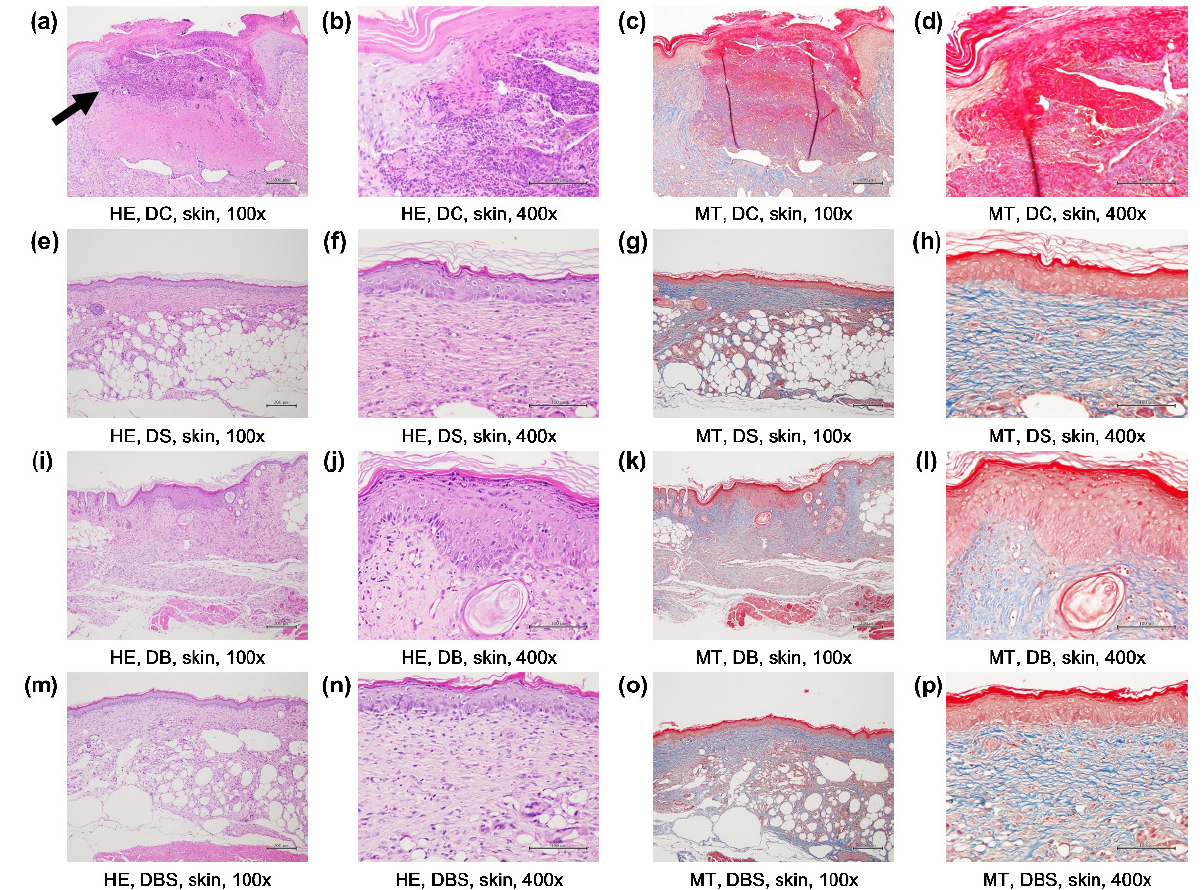
Figure 5. Histopathological analysis of skin wounds treated with different dressings. Histopatho- logical findings upon hematoxylin and eosin (H&E) and Masson’s trichrome (MT) staining of skin wounds of diabetic mice on day 21. All figures shown are magnified at 100 × or 400 × . ( a – d ), DC, wounded diabetic mice treated with gauze; ( e – h ), DS, wounded diabetic mice treated with Suile; ( i – l ), DB, wounded diabetic mice treated with bacterial fiber membrane; ( m – p ), DBS, wounded diabetic mice treated with bacterial fiber membrane and Suile. HE-stained images show inflammation as dark purple (marked by arrow). MT-stained images show neo-epidermis as dark red, granule tissue as light red, and collagen fiber as